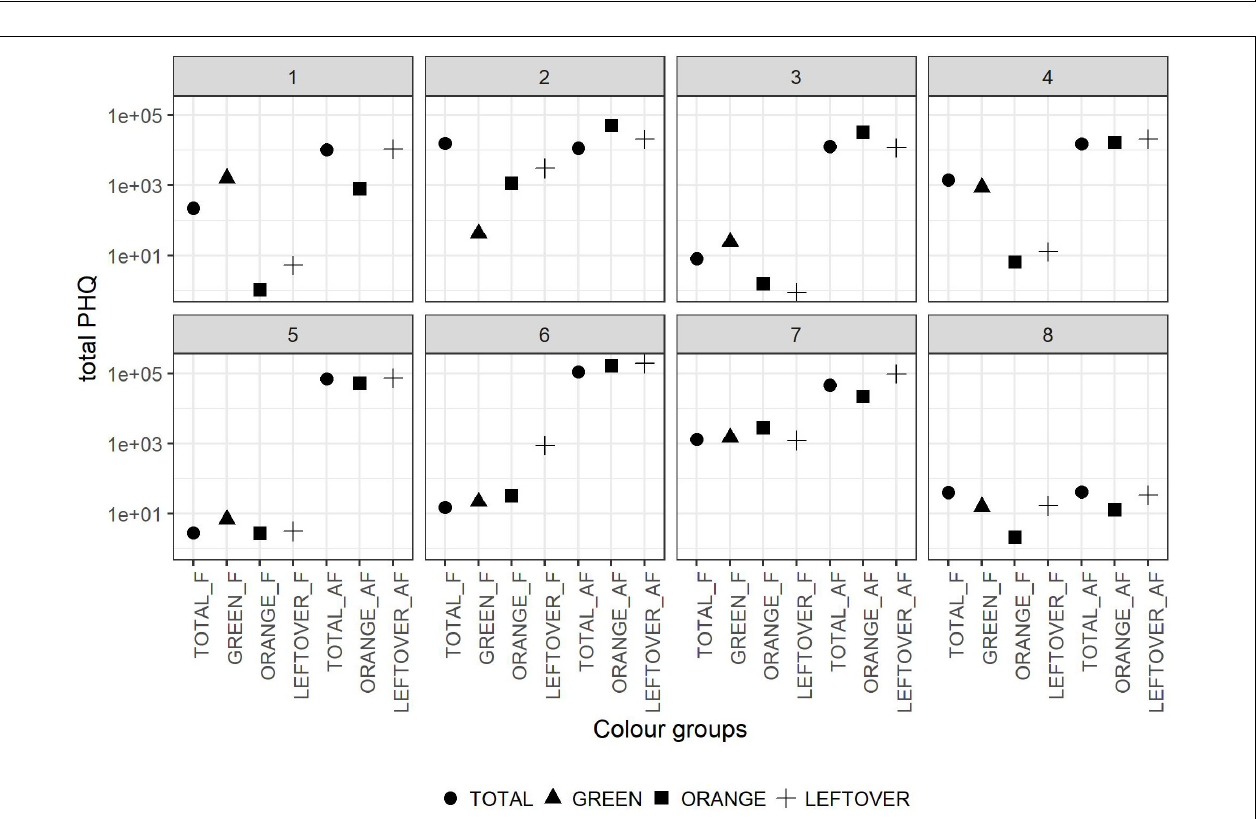
FIGURE 5 | Total PHQ of the pollen color groups in the eight locations. Dots shapes refer to the pollen color group. The values in y-axis are reported in logarithmic scale. In the x-axis the labels combine the pollen group and the collection period (F = apple flowering, AF = after apple flowering).